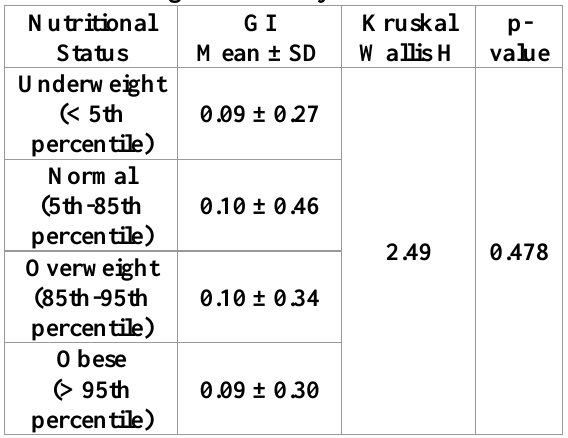
Table 7: Gingival index by nutritional